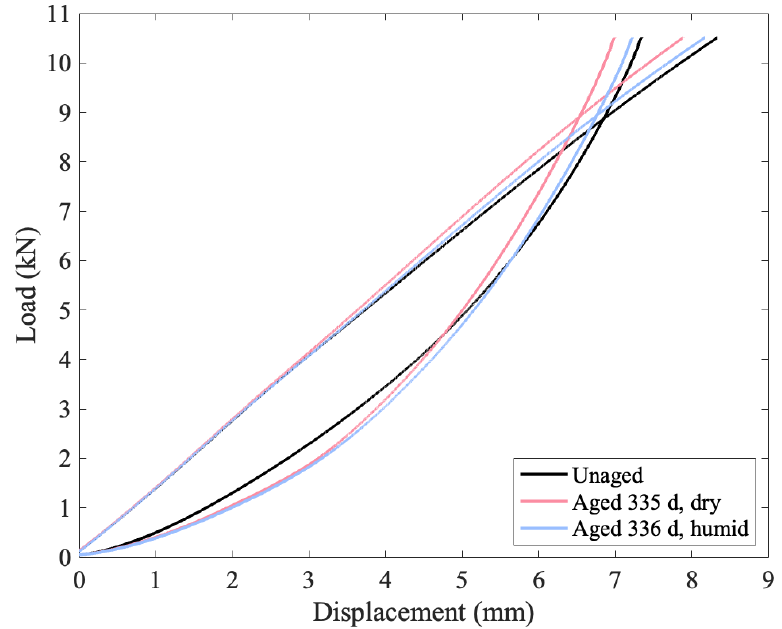
Figure 11. Comparison of the final loading and unloading cycles for all three specimens that under- went the cyclic testing.